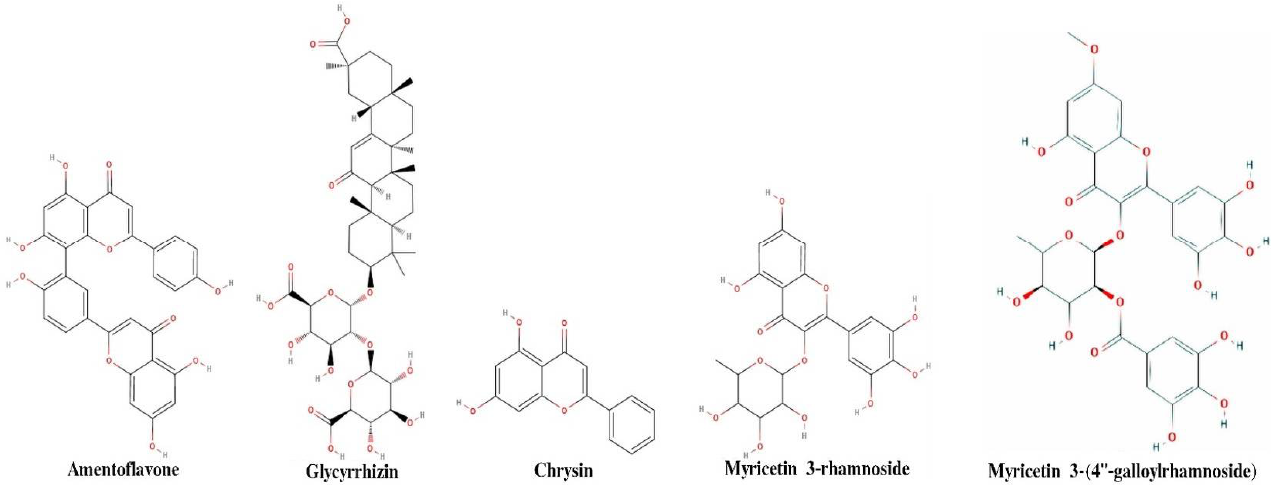
Figure 2. 2-D representation of five ligands that show maximum binding affinity with 6M0J. Table 2. Drug likeness properties of phytocompounds .